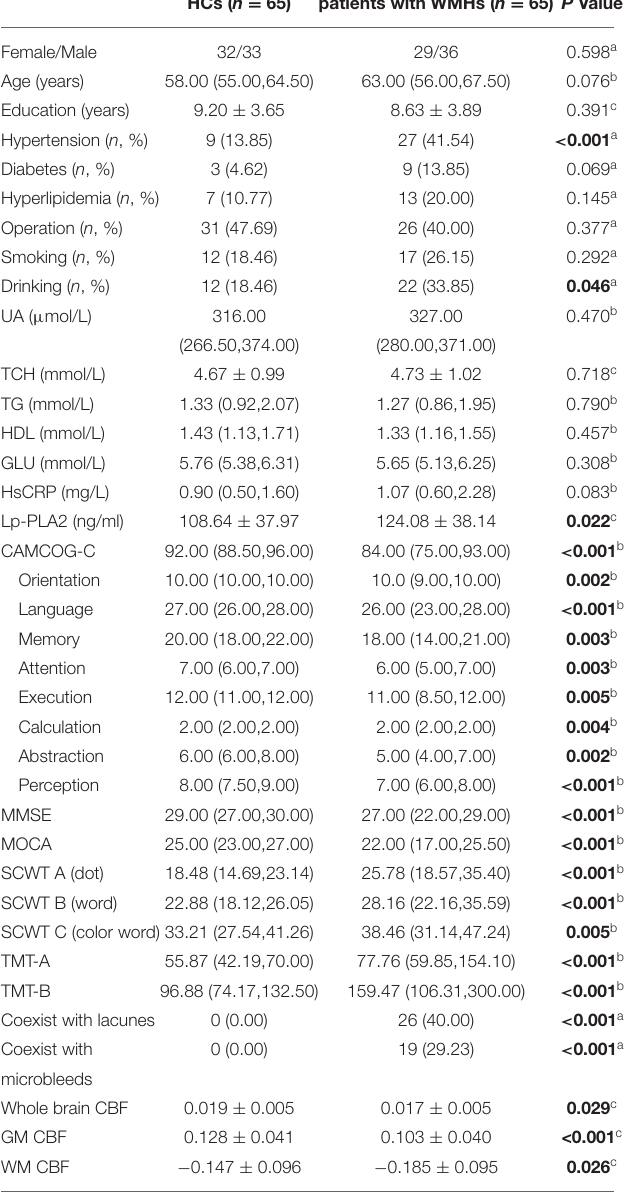
TABLE 2 | The results of the logistic regression analysis of clinical risk factors for WMHs.